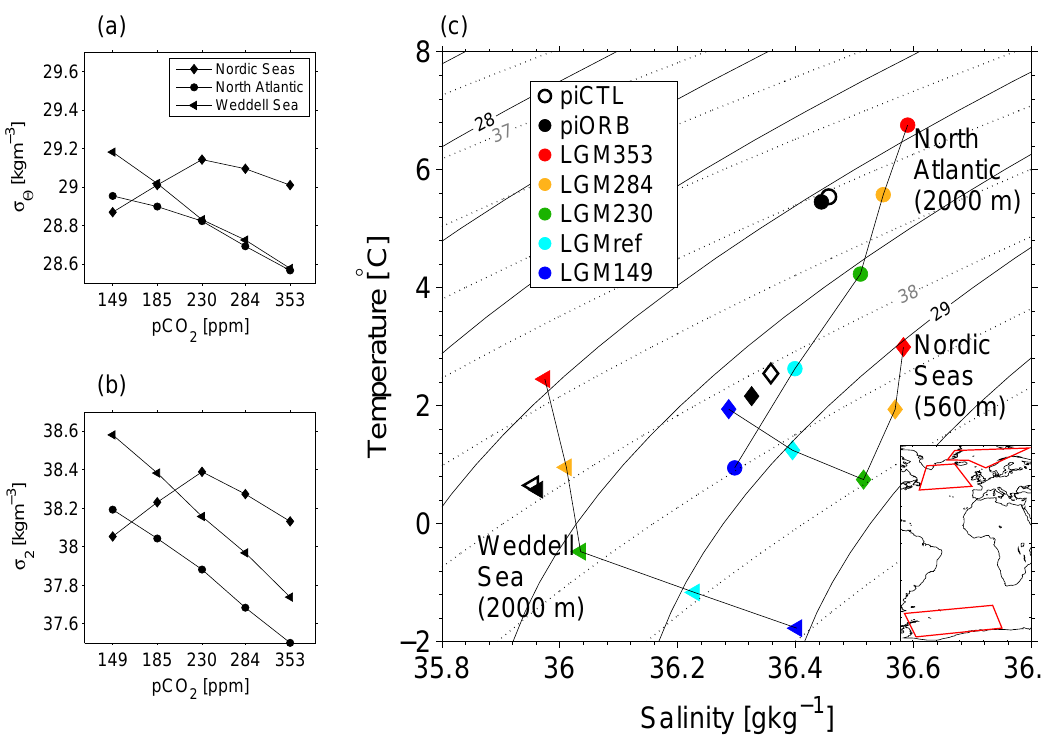
Figure 10. Maximum of (a) σ (cid:50) and (b) σ 2 at 560m in the Nordic Seas and at 2000m in the North Atlantic and Weddell Sea as a function of p CO 2 in the glacial setup. (c) Temperature and salinity corresponding to the maximum density in each region. Solid contours indicate σ (cid:50) , and dotted contours indicate σ 2 . The contour interval is 0.2kgm − 3 . For an easier comparison with the glacial setup runs, the salinity of piCTL and piORB has been offset by 1.21gkg − 1 to account for the global mean salinity difference caused by the lower glacial sea level. The small map shows the definition of the three selected